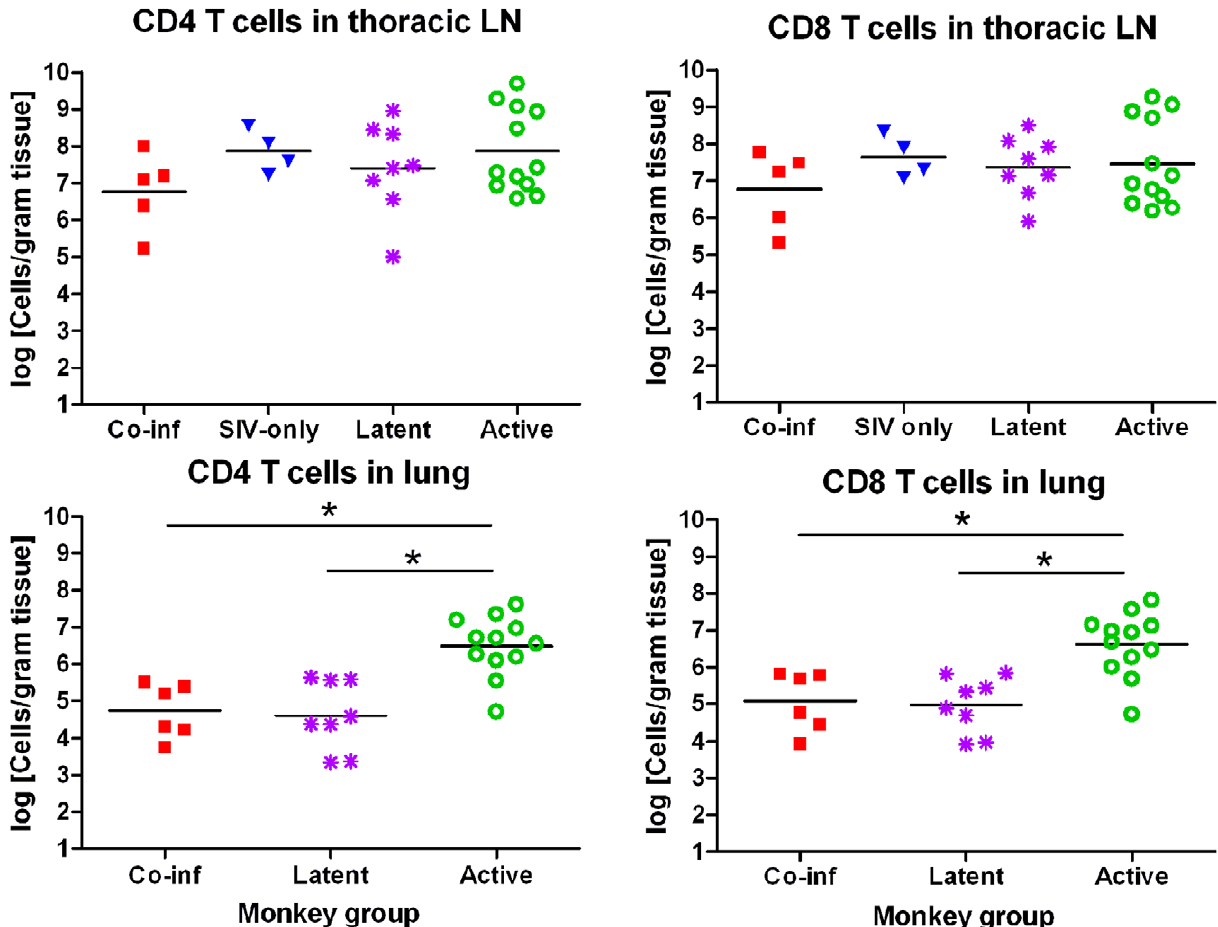
Figure 7. CD4 and CD8 T cell numbers in lung and thoracic lymph nodes. CD4 and CD8 T cell numbers in lung-draining thoracic lymph nodes (LN) are not significantly different between co-infected animals and animals with latent or active TB. T cell numbers in co-infected lung tissues were similar to animals with latent TB but significantly lower than animals with active TB (Mann-Whitney, CD4 P=0.0023; CD8 P=0.0078). Latent monkeys have fewer lung T cells than active monkeys (Mann-Whitney, CD4 P=0.0014; CD8 P=0.0018). Data points represent average T cell numbers from either thoracic LN or lung tissue from each monkey. Not all co-infected monkeys are not present due to limited tissue availability.